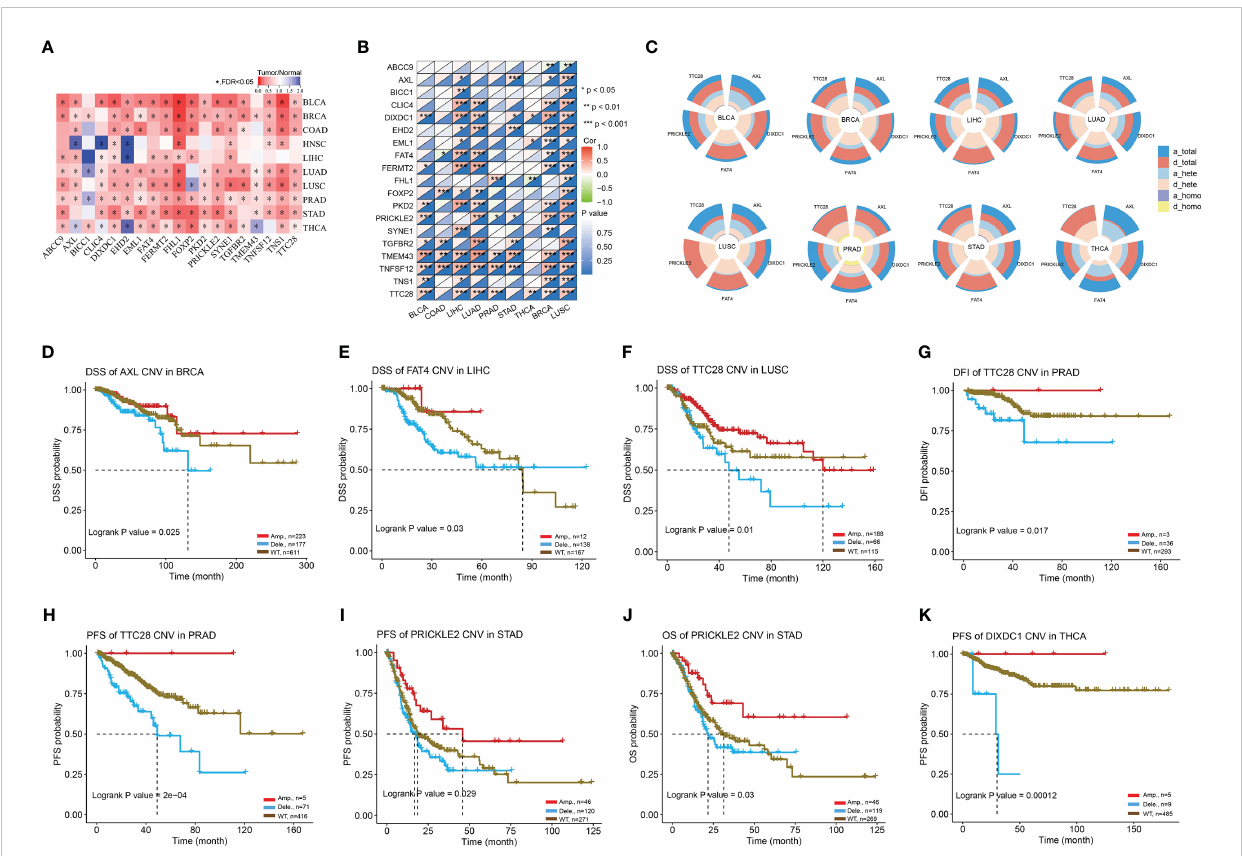
FIGURE 10 CNV mutation landscape of ABI3BP-related genes. (A) ABI3BP-related gene expression levels in pan-cancer patients. (B) Correlation between CNV mutations and mRNA levels of ABI3BP-related genes. (C) Percentage of CNV in AXL, DIXDC1, FAT4, PRICKLE2, and TTC28. (D-K) Association between CNV mutations and prognosis in patients with BRCA, LIHC, LUSC, PRAD, STAD, and THCA. *, p < 0.05; **, p < 0.01; ***, p < 0.001.